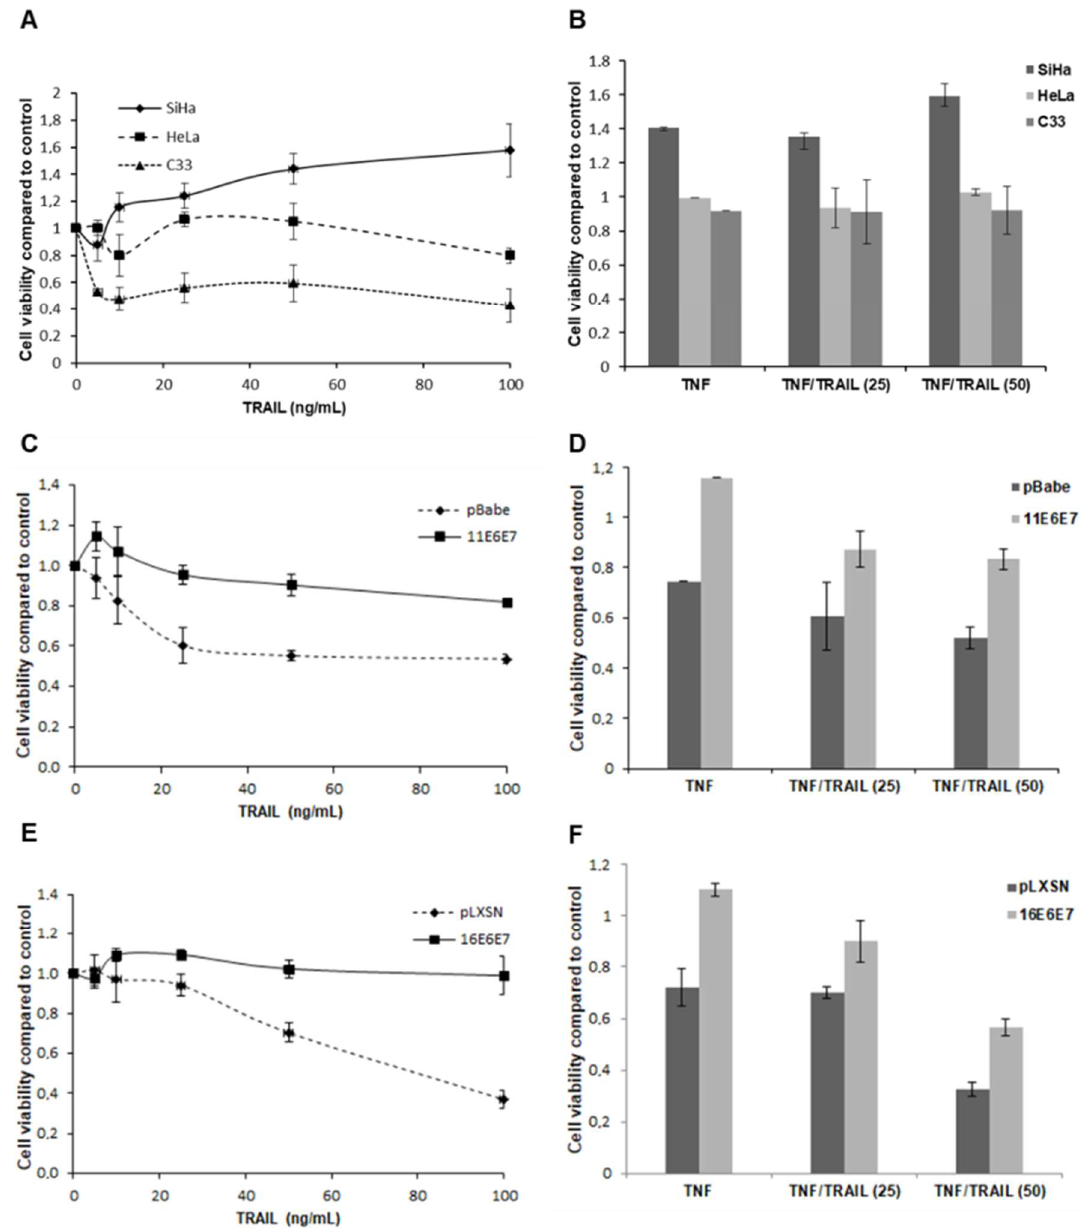
Figure 1. Expression of HPV genes E6 and E7 confers resistance to pro-inflammatory cytokines TNF and TRAIL. Effect of TNF and TRAIL on cervical cancer-derived cell lines ( A , B ) and PHK transduced with E6 and E7 of HPV11 ( C , D ) or HPV16 ( E , F ) cell viability. Cells were seeded in 96 wells plates (2000 cells/well) and after 24 h they were treated with 5, 10, 25, 50 or 100 ng/mL of TRAIL ( A , C , E ), with 2 nM TNF ( B , D , F ) or with 2 nM TNF plus 25 or 50 ng/mL of TRAIL ( B , D , F ). All treatments were performed in octuplicate. After 60 h 10 µ L of Alamar blue were added per well and cells were incubated at 37 ◦ C in an incubator for at least 4 h. After this period, Alamar Blue’s reduction was monitored in a spectrophotometer through absorbance measurement at 570 e 600 nm. The results presented are representative of three independent experiments. All data are presented as values relative to control.